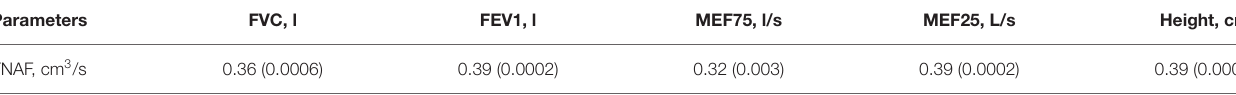
The data is presented as R (p), where R is the correlation coefficient and p is the level of statistical significance. TNAF, cm 3 /s—total nasal airflow; FVC, l—forced vital capacity of the lungs; FEV1, l—forced expiratory volume in 1s; MEF75, l/s—maximum expiratory velocity at point 75% of the